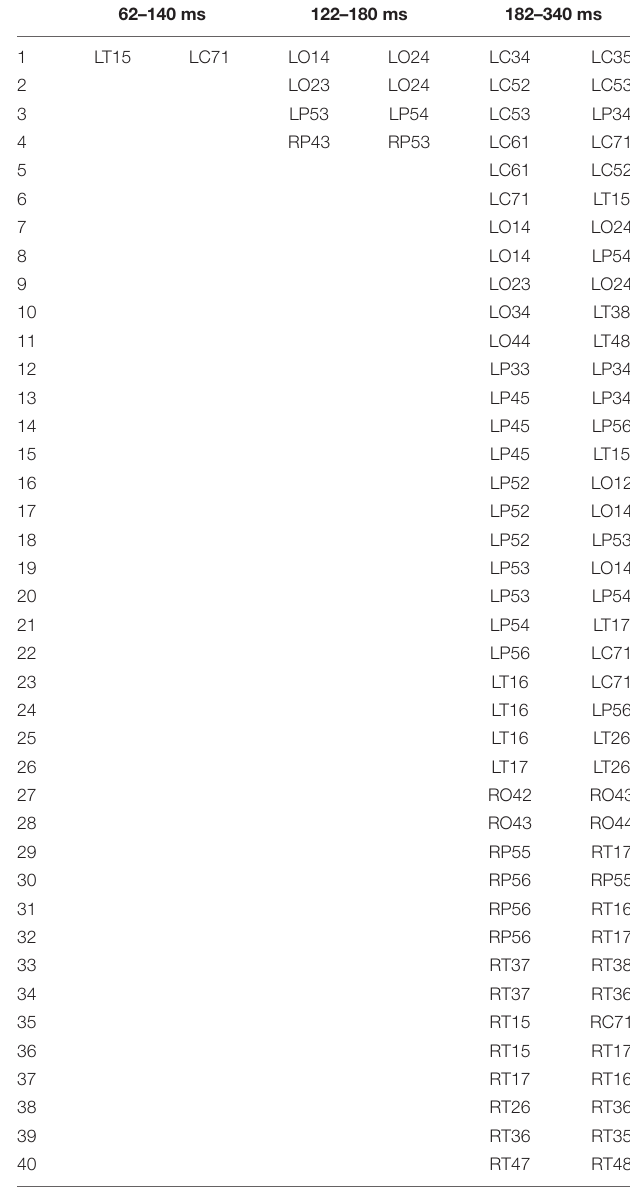
Channel pairs showing correlation coefficient r-values over 0.8 in each time domain during MBJs. Time windows are in reference to Decety and Cacioppo